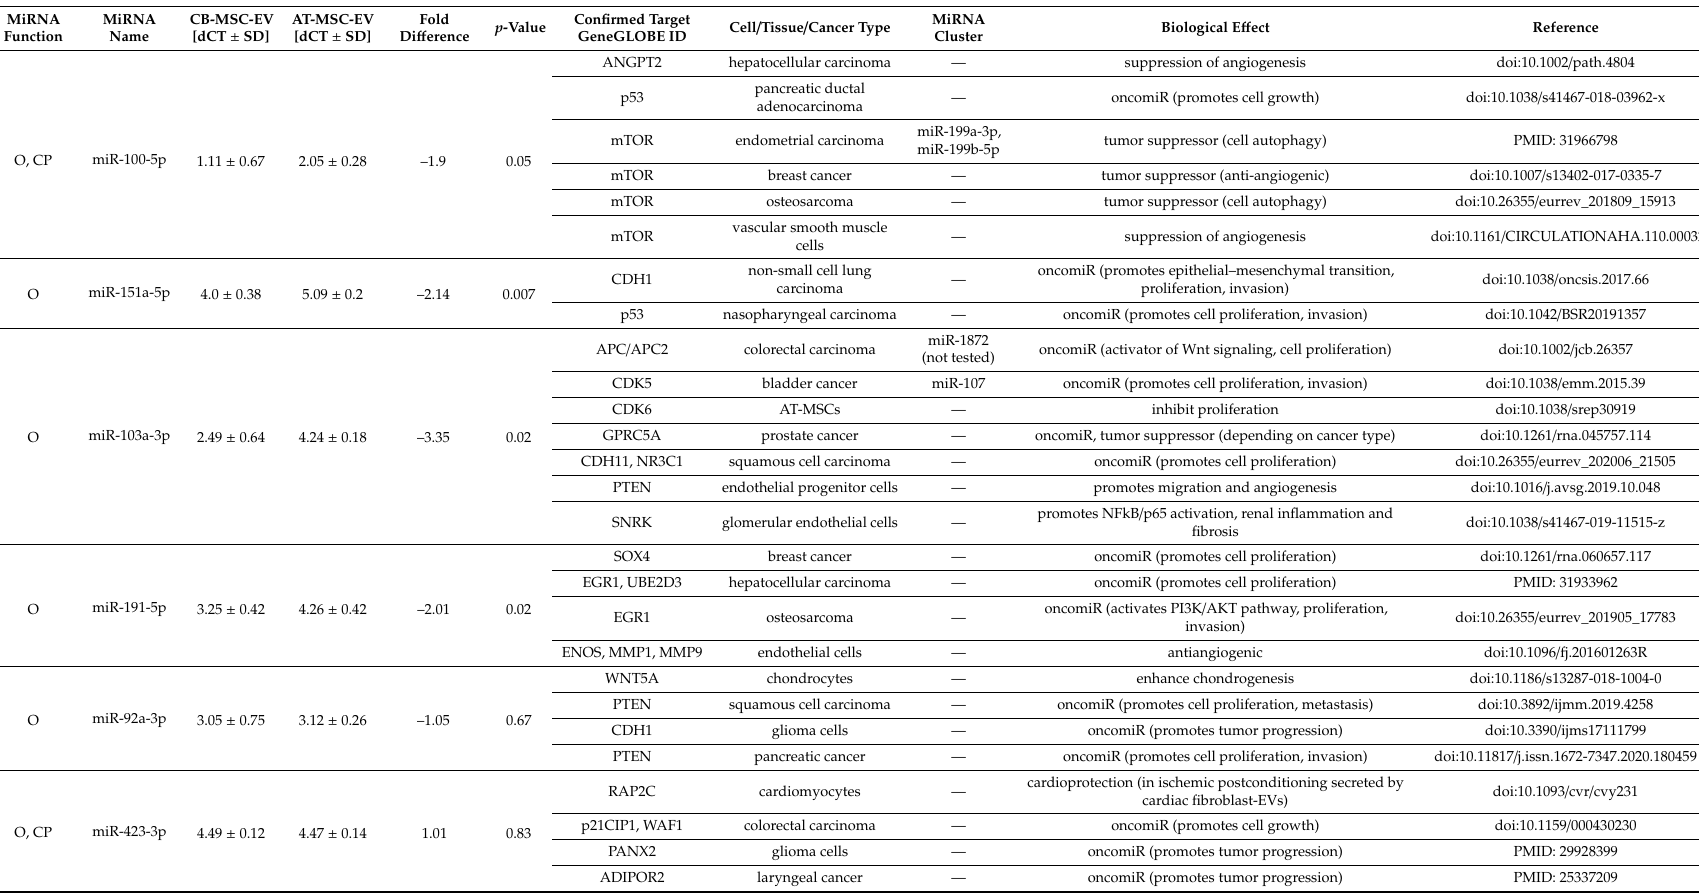
Table A2. MiRNAs that are known oncomiRs (O). Selected miRNAs are also involved in cardioprotection (CP). Targets are given for each miRNA, with no claim to completeness. Pubmed IDs (PMIDs) are given as references when no doi numbers are